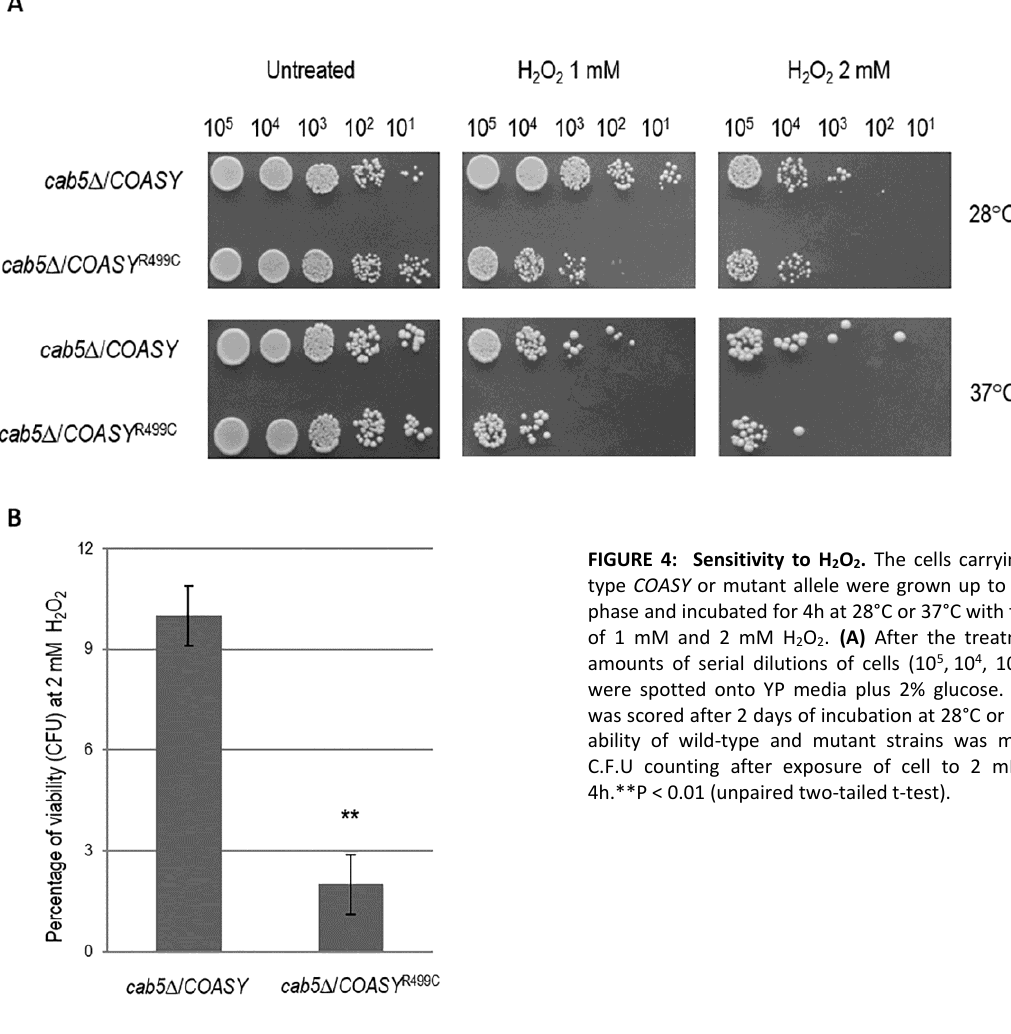
FIGURE 4: Sensitivity to H 2 O 2 . The cells carrying the wild- type COASY or mutant allele were grown up to exponential phase and incubated for 4h at 28°C or 37°C with the addition of 1 mM and 2 mM H 2 O 2 . (A) After the treatment, equal amounts of serial dilutions of cells (10 5 , 10 4 , 10 3 , 10 2 , 10 1 ) were spotted onto YP media plus 2% glucose. The growth was scored after 2 days of incubation at 28°C or 37°C. (B) Vi- ability of wild-type and mutant strains was measured by C.F.U counting after exposure of cell to 2 mM H 2 O 2 for 4h.**P < 0.01 (unpaired two-tailed